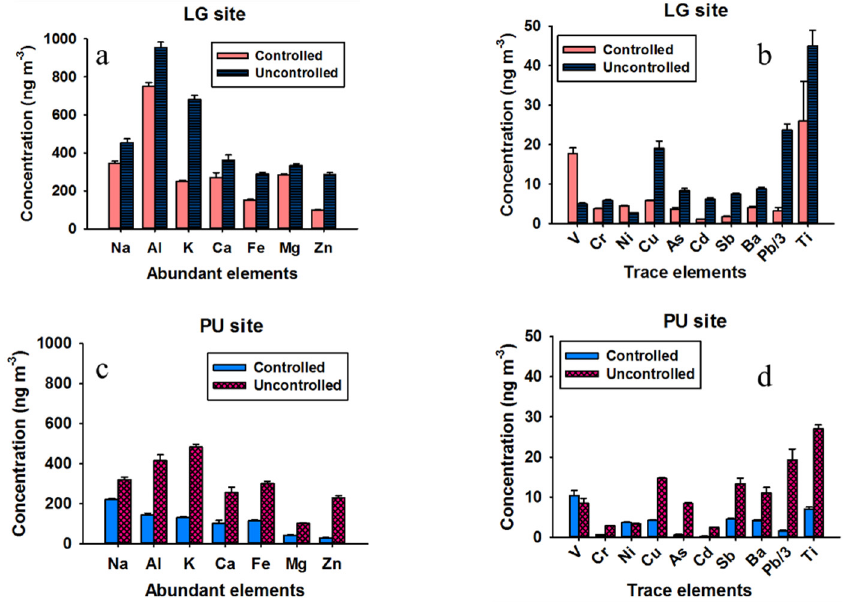
Figure 2. Average (ng·m − 3 ) abundant and trace elements observed in PM 2.5 at the LG site ( a , b ) and PU site ( c , d ) during controlled and uncontrolled periods.